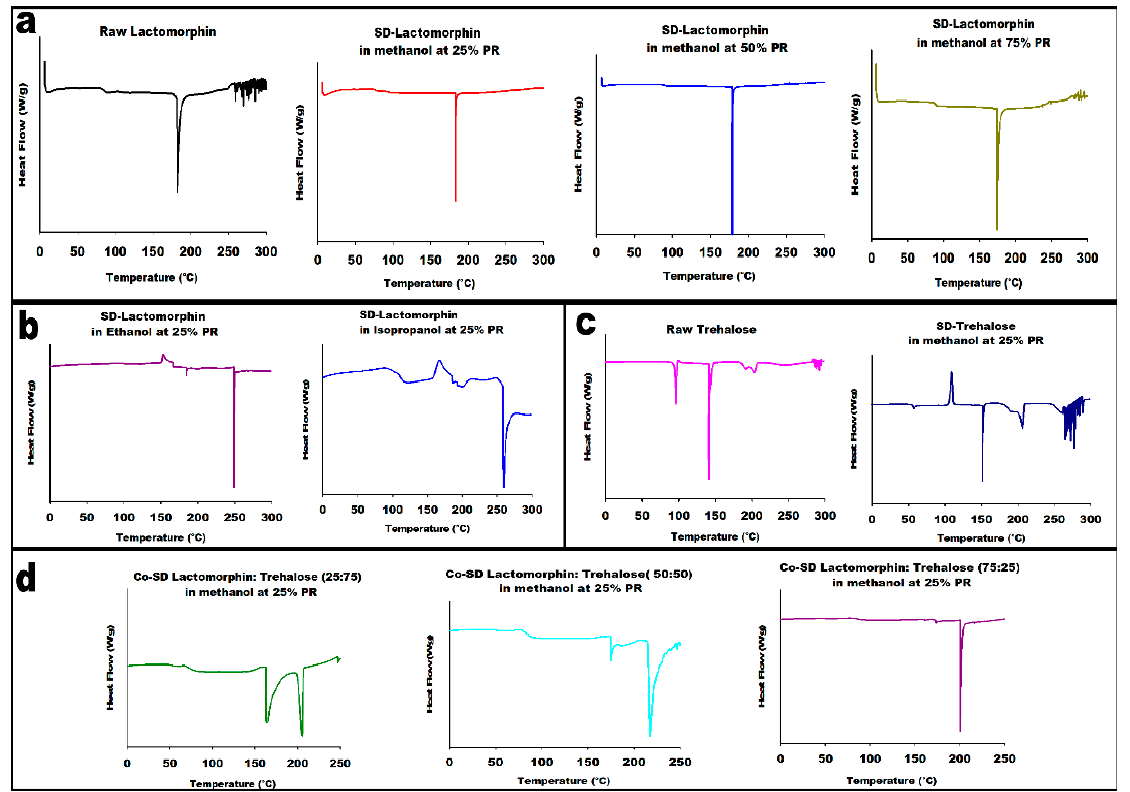
Figure 4. Differential scanning calorimetry thermograms of ( a ). SD-Lactomorphin particles at three pump rates versus raw Lactomorphin; ( b ). SD-Lactomorphin particles in ethanol and isopropanol at 25% pump rate; ( c ). SD-Trehalose particles at 25% pump rate in methanol versus raw Trehalose; ( d ). formulated co-SD-Lactomorphin:Trehalose at a different molar ratio in methanol at 25% pimp rate.